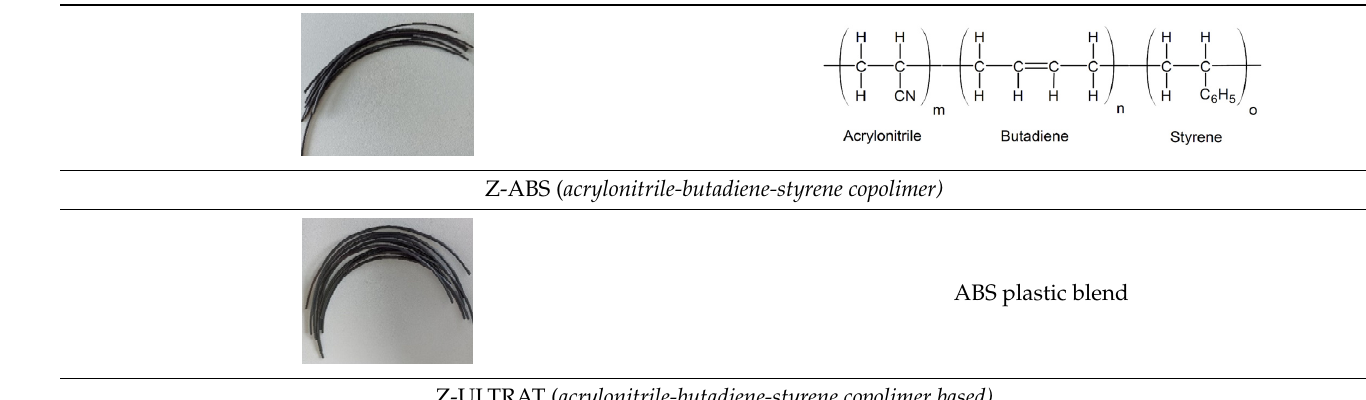
Table 1. Samples of commercially available 3D printing fi laments.